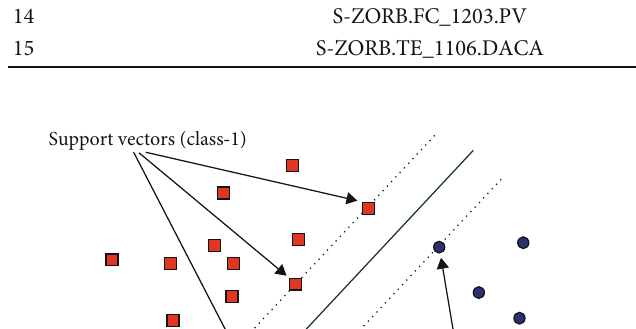
Table 9: RF model